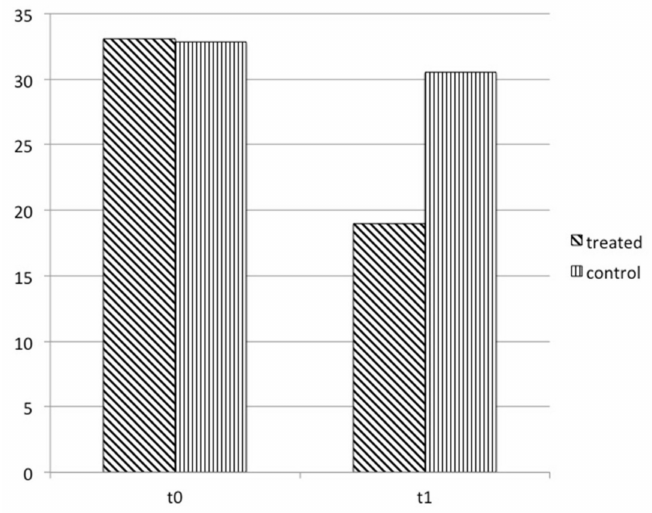
Figure 1. CVSS17 questionnaire score in treated group and in control at enrollment and 1 month later. The score significantly improved from t0 to t1 in treated.